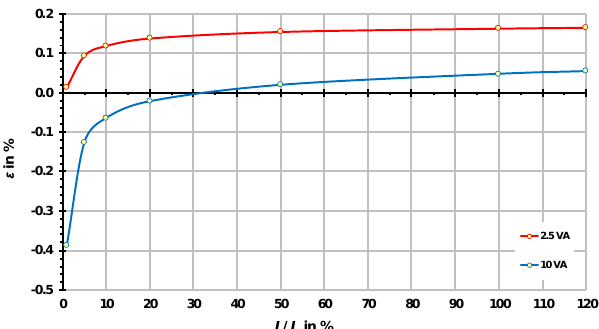
Figure 4. Ratio error of a class 0,2S current transformer (Mohns,